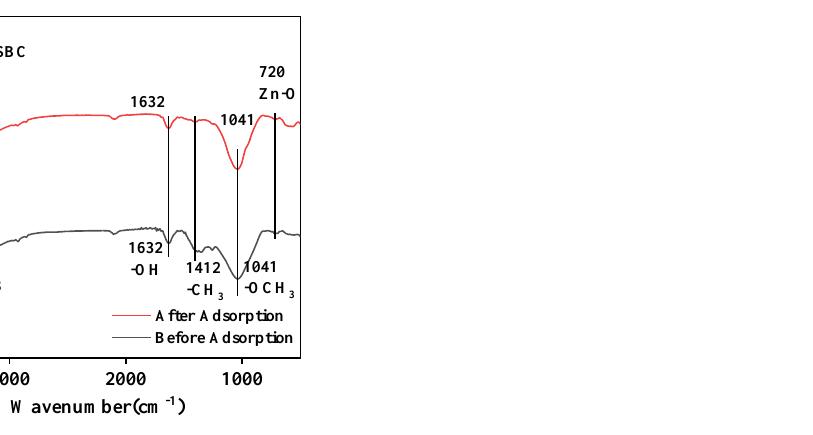
Figure 1. FTIR results before and after adsorption of nZVZ–MSBC. The existence of C, O, Zn, and P elements in nZVZ–MSBC was proven by XPS. The total XPS measurement spectrum (Figure 2a) showed that the material’s prominent ele- ment peaks (eV) were C 1s, O 1s, Zn 2p, and P 2p. The high-resolution C 1s spectrum revealed four peaks: C–H (284.4 eV), C–C (285.2 eV), C–O (286.6 eV), and COOH (289.2 eV) (Figure 2b) [19,20]. The binding energy of O 1s had two peaks at 532 eV and 533.4 eV, corresponding to C–O and chemisorbed oxygen (O C ) (Figure 2c) [21]. However, C–O, with a larger peak area, still dominated the fitting. Figure 2d shows that Zn 2p can be deconvoluted into two parts, Zn 2p 1/2 (1045.5 eV) and Zn 2p 3/2 (1022.4 eV) [22]. This was similar to the binding energy of conventional Zn-X-LDX/LDO previously reported (where X represents other metals) [23,24]. Unlike the material before adsorption, the P element appeared in the composite after adsorption. The high-resolution P 2p spectrum in Figure 2e shows three binding types at 133.4 eV, 133.9 eV, and 134.4 eV, respectively, corresponding to P 2p 3/2 , P 2p, and P 2p 1/2 [20].